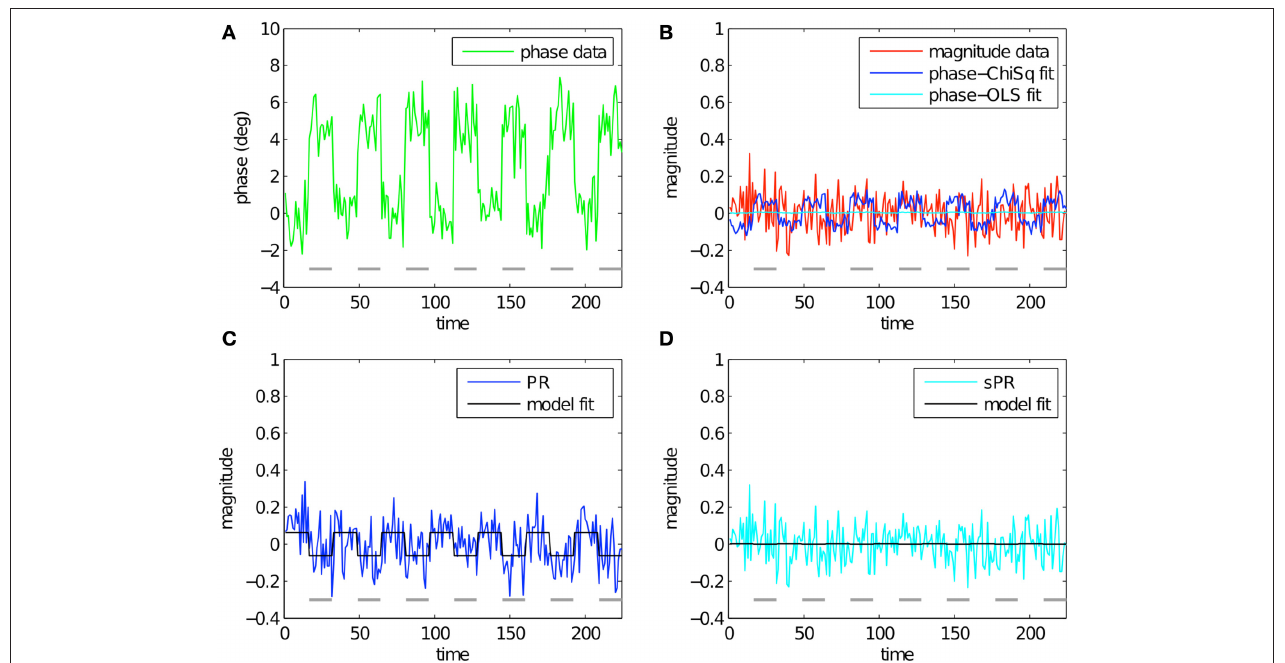
FIGURE 5 | Simulated large vein suppression in a voxel adjacent to a large vein. In this regime, phase fSNR is high but magnitude fSNR is low. (A) Phase timecourse is plotted in green ( t = 4.55 ). Gray dashes indicate stimulus-on periods. (B) Magnitude timecourse is plotted in red ( t = 0.02 ). Linear fits of phase to magnitude using L ChiSq and L OLS are plotted in blue and cyan, respectively. Using L ChiSq yields larger absolute fits (e.g., larger b * 1 values). (C) PR large vein suppressed timecourse is plotted in blue ( t = − 1.22). PR model fit timecourse is plotted in black. (D) sPR large vein suppressed timecourse is plotted in cyan ( t = − 0.02). sPR model fit timecourse is plotted in black. In this regime, PR overestimates b * 1 resulting in artifactual BOLD activity. sPR yields unbiased estimates of b * 1 and correctly estimates the large vein suppressed BOLD timecourse as the magnitude timecourse.